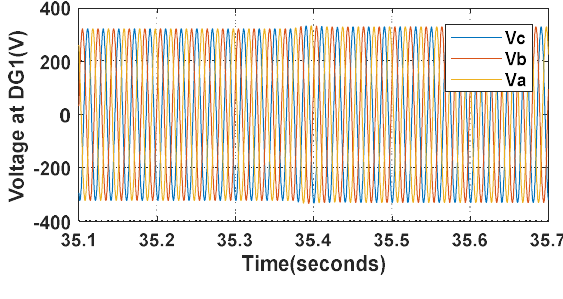
Energies 2020 , 13 , x FOR PEER REVIEW Figure 15. Phase Voltages at DG1 bus. Figure 15. Phase Voltages at DG1 bus.